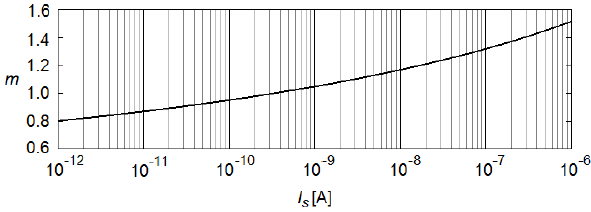
Figure 4. The relationship between the diode ideality factor m and the diode saturation current I S , approximated by Equation (3). A generic value for the open-circuit voltage, V = 0.6 V, has been considered.